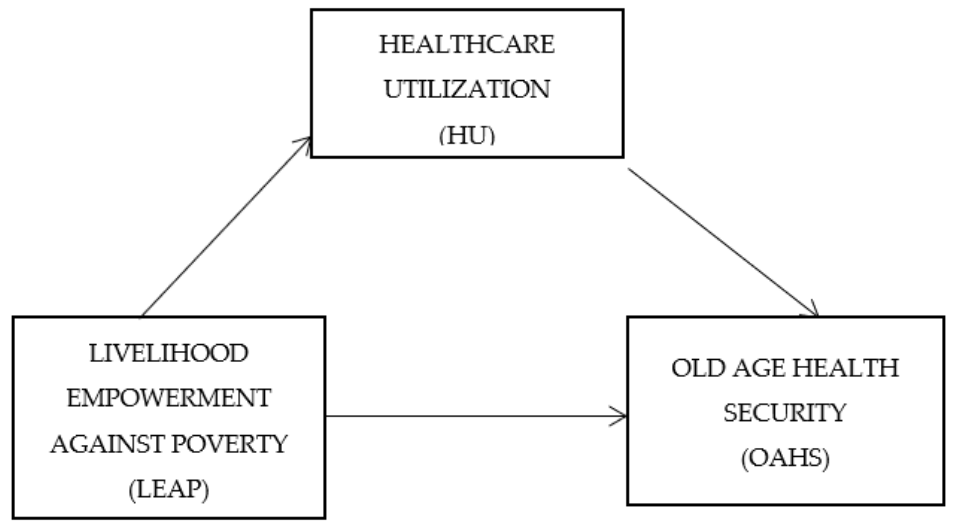
Figure 1. Conceptual model.